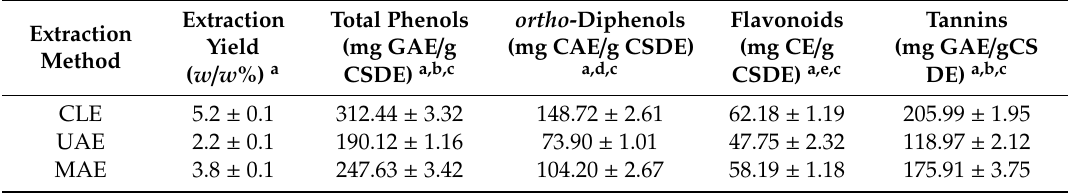
Table 1. Extraction yield, total phenols, and phenolic families in dry extracts from chestnut shells.